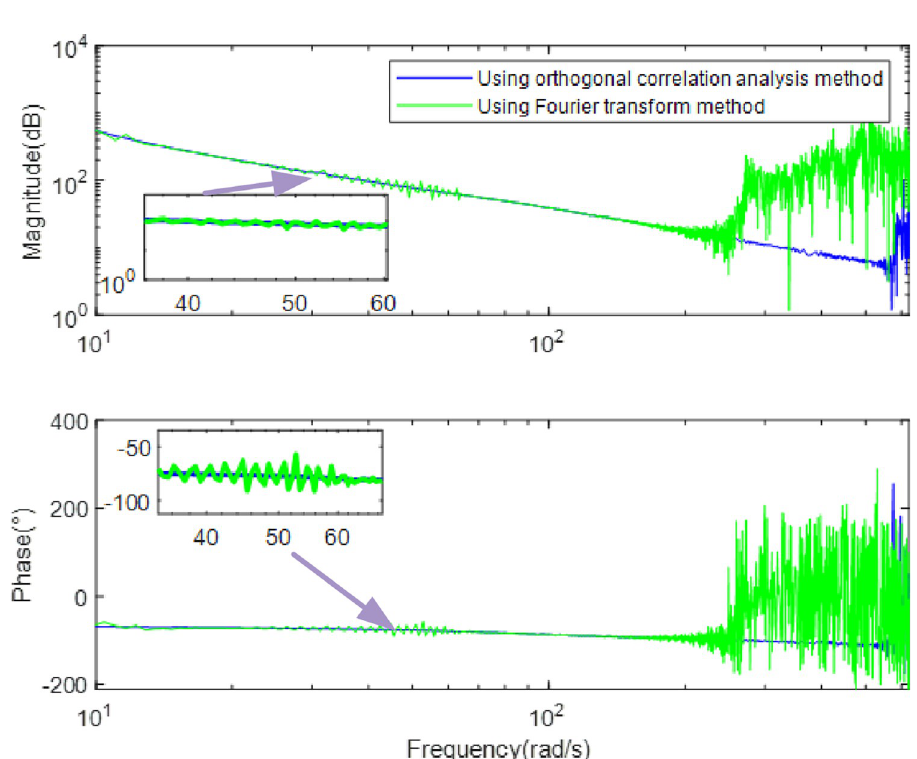
Fig 13. Comparison of frequency characteristic curves obtained by orthogonal correlation analysis and Fourier transform method. https://doi.org/10.1371/journal.pone.0267450.g013 PLOS ONE | https://doi.org/10.1371/journal.pone.0267450 August 18,